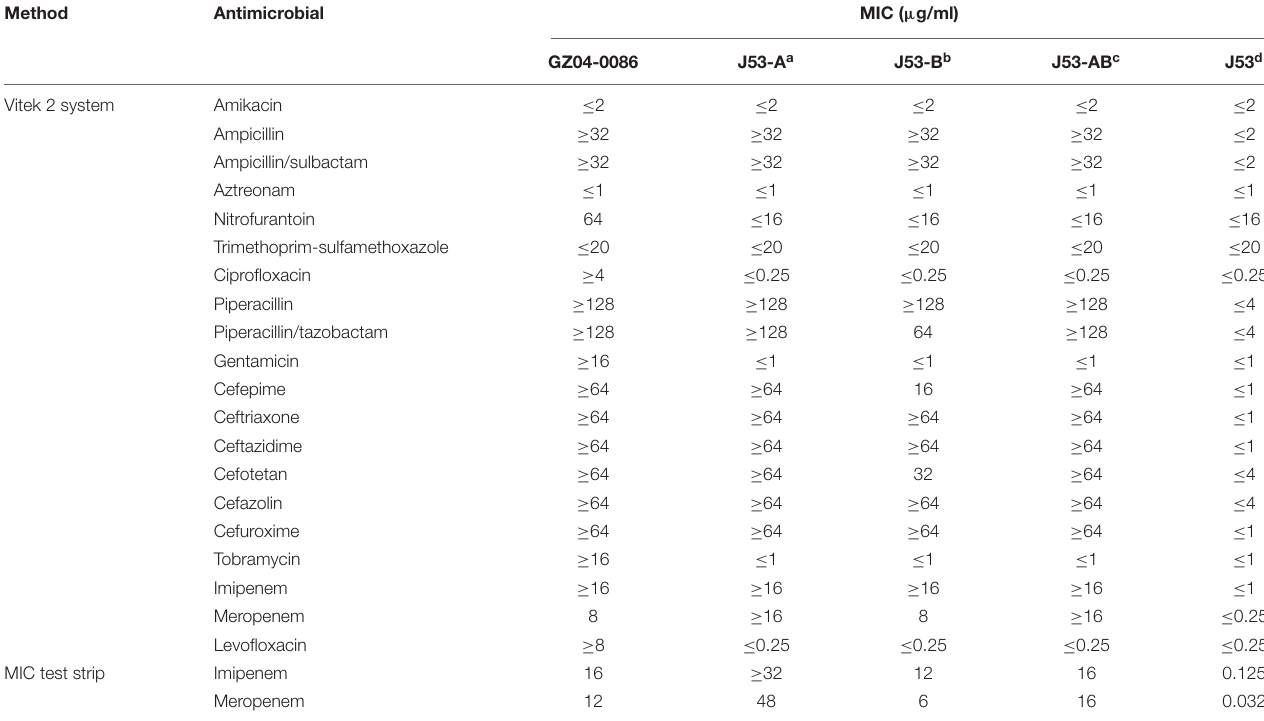
TABLE 1 | Antibiotic susceptibilities of E. coli strain GZ04-0086, the E. coli J53 transconjugants and the E. coli J53 recipient.